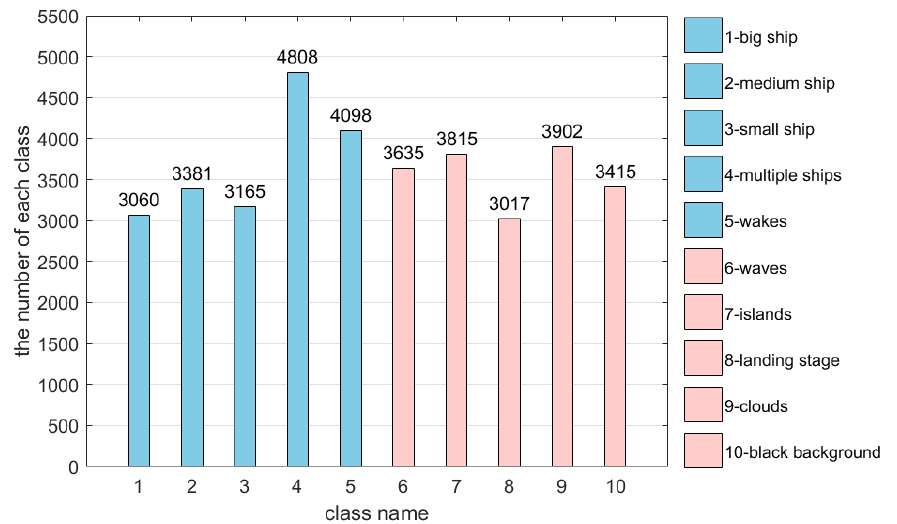
Figure 9. Distribution of each class in the dataset (36,296 in